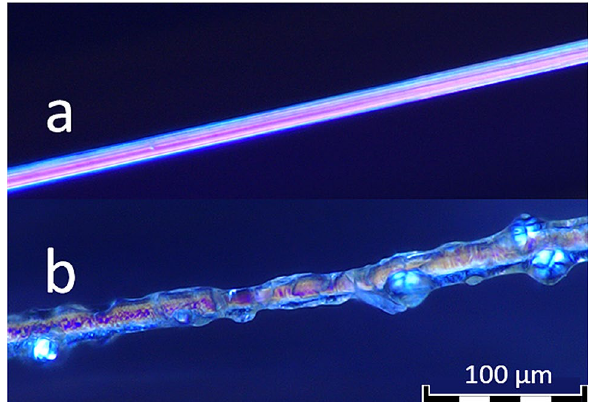
Figure 8. Digital microscope scan of an untreated viscose filament ( a ) and a filament subjected to 3 days immersion in isocyanate hardener ( b ), observation method: PO (polarization), objective lens: DSX10- XLOB20X, zoom: ×2.5, total magnification: ×700.